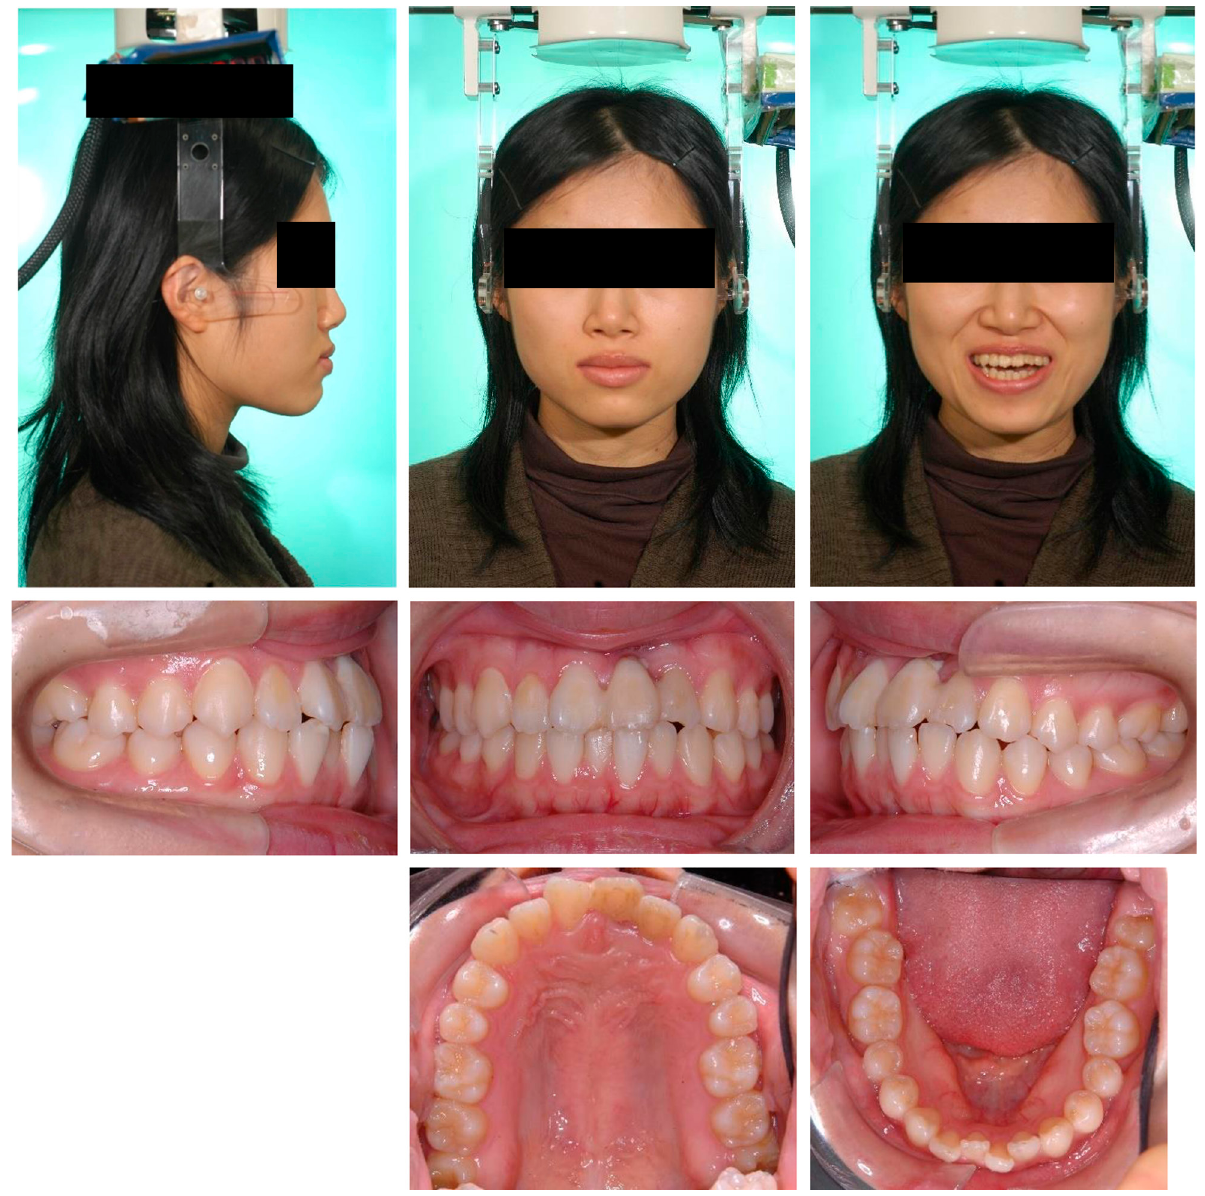
Figure 1. Pretreatment facial and intraoral